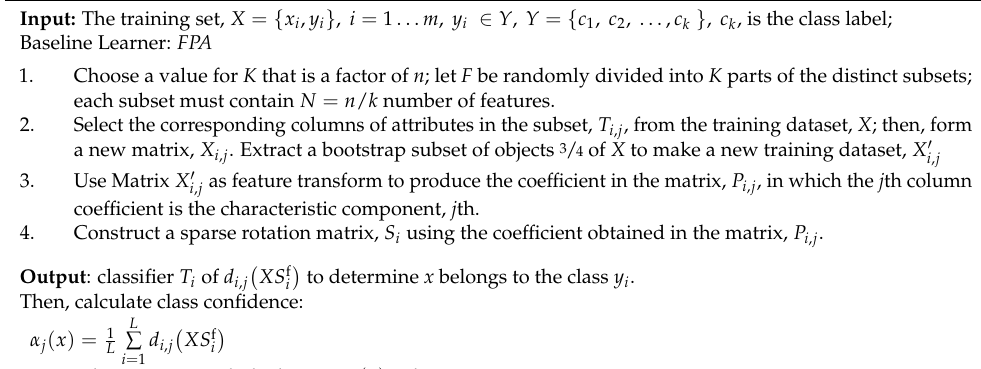
Algorithm 2: Rotation Forest-based Forest Penalizing Attribute (RoF_FPA)